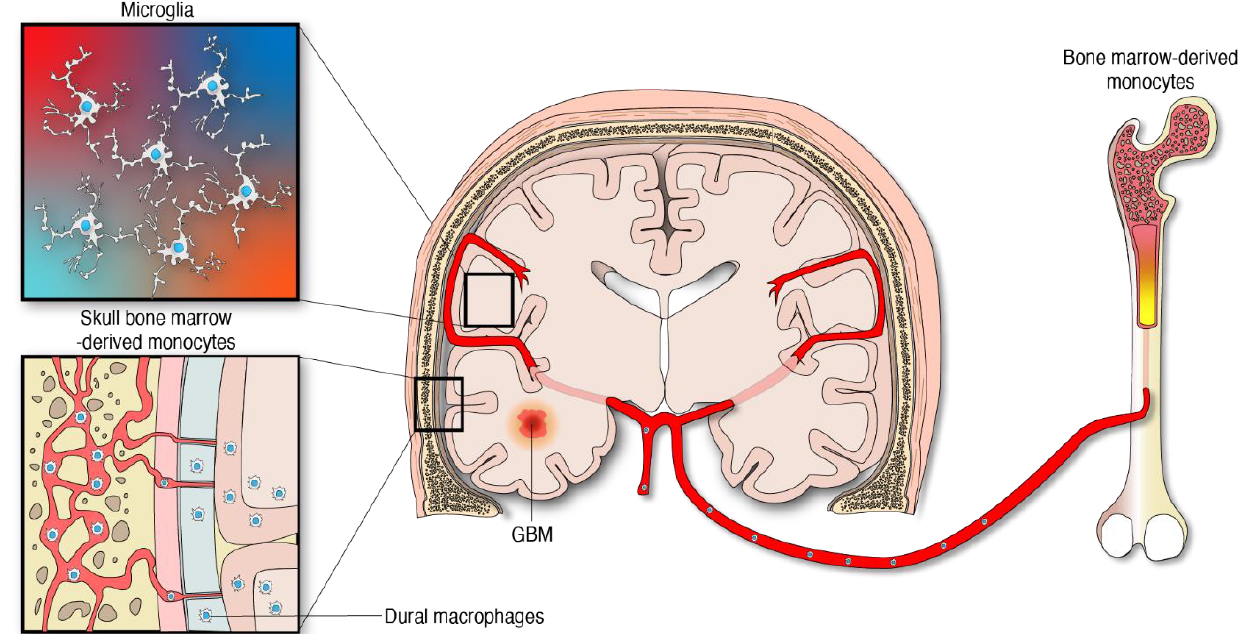
Figure 1. Myeloid cells from different anatomical and embryological origins contribute to the cellular heterogeneity in gliomas.